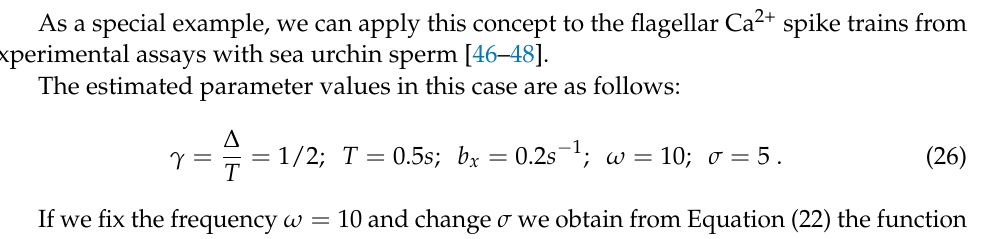
Figure 8. The 3D plateau-like function of cumulative activation of the target protein.